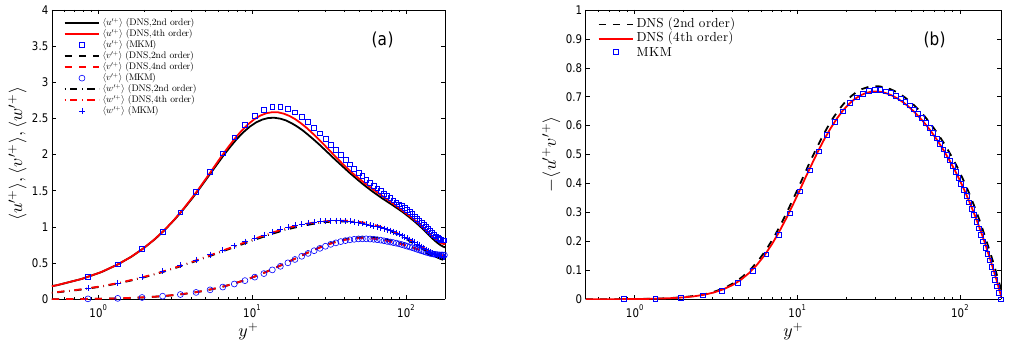
Figure 9. ( a ) R.m.s of velocity fluctuations and ( b ) tangential Reynolds stress of turbulent channel flow at Re τ = 180 by DNS.